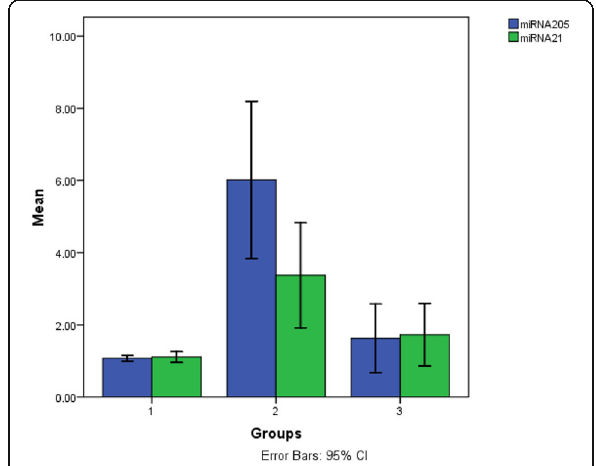
Fig. 2 Expression values of the miRNA-205 and miRNA-21 in different groups